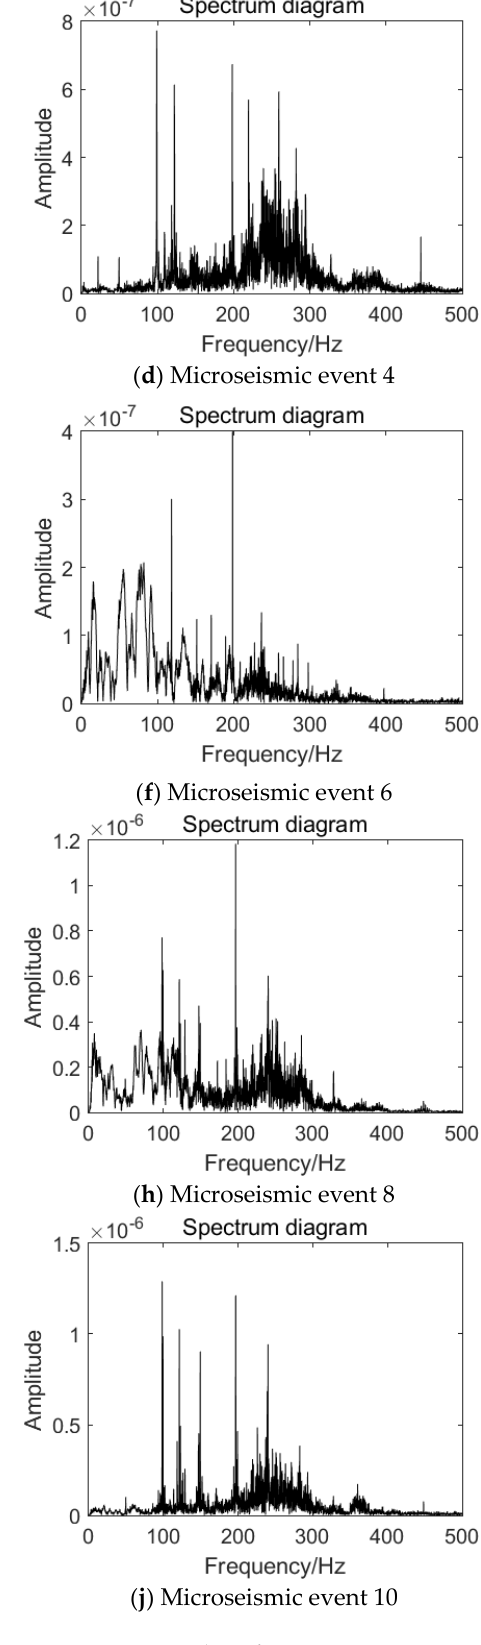
Figure 5. Waveform spectrum of microseismic events in working face.